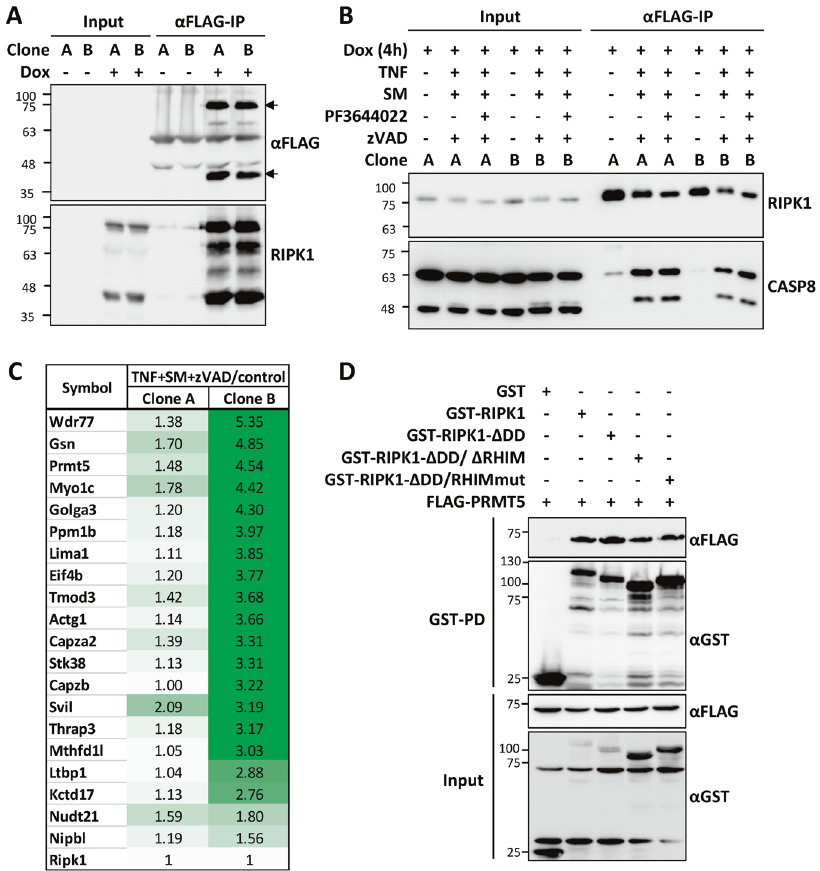
Fig. 1 A screen for ripoptosome interactors identi fi ed PRMT5 as an interaction partner of RIPK1. A Two clonal cell lines generated by retroviral transduction and single-cell cloning of RIPK1-de fi cient fi broblasts with doxycycline (Dox) inducible FLAG-tagged mRIPK1 expression vector were left untreated or treated with Dox for 9 h. RIPK1 was enriched by FLAG-immunoprecipitation and detected in immunoblots with antibodies against FLAG tag and RIPK1. B The cells were treated as indicated (30 min pre-treatment with inhibitors followed by 120 min TNF) and subjected to FLAG-IPs as in panel A. Blots were probed with CASP8 antibodies to monitor assembly of the ripoptosome. C Consistent RIPK1 interaction partners identi fi ed in both clonal lines by mass spectrometry screen are represented with the fold enrichment between TNF + SM + zVAD treated and untreated conditions. D GST-pulldown assay shows speci fi c interaction of RIPK1 with PRMT5, independent of death domain (DD) and RHIM motif of